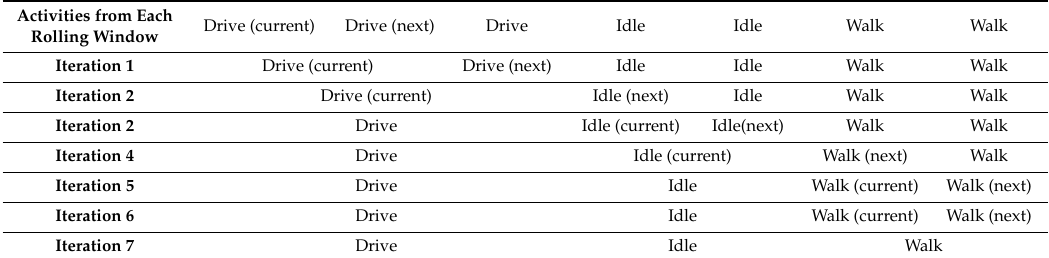
Table 4. Example of context flow recognition